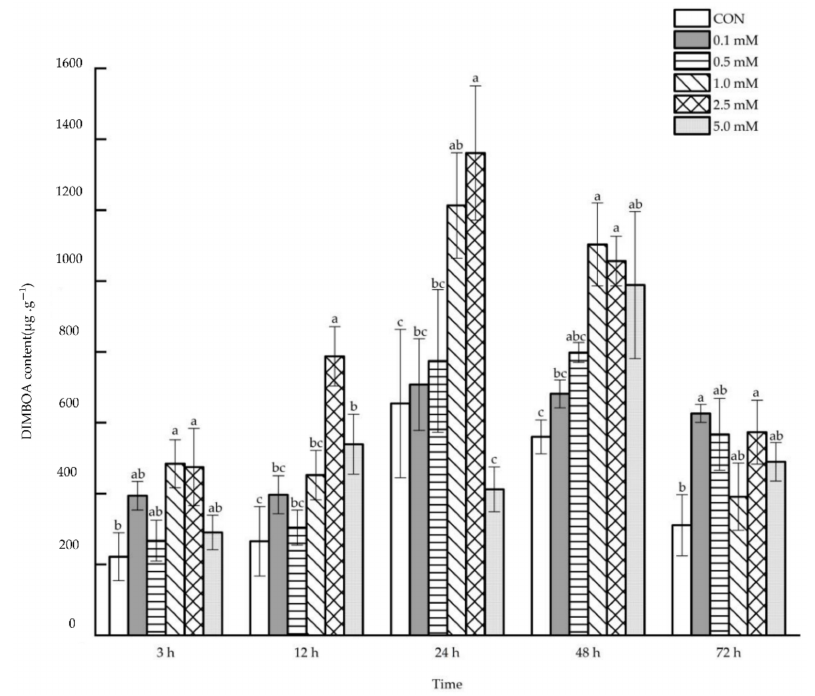
Figure 7. The systemic effect of the SA concentration and post-treatment time on the DIMBOA content in roots following exogenous foliar application. The data are presented as mean ± standard errors. The significance of data was determined by the Duncan method. The difference between different letters at the same time reached significant levels of 5%.